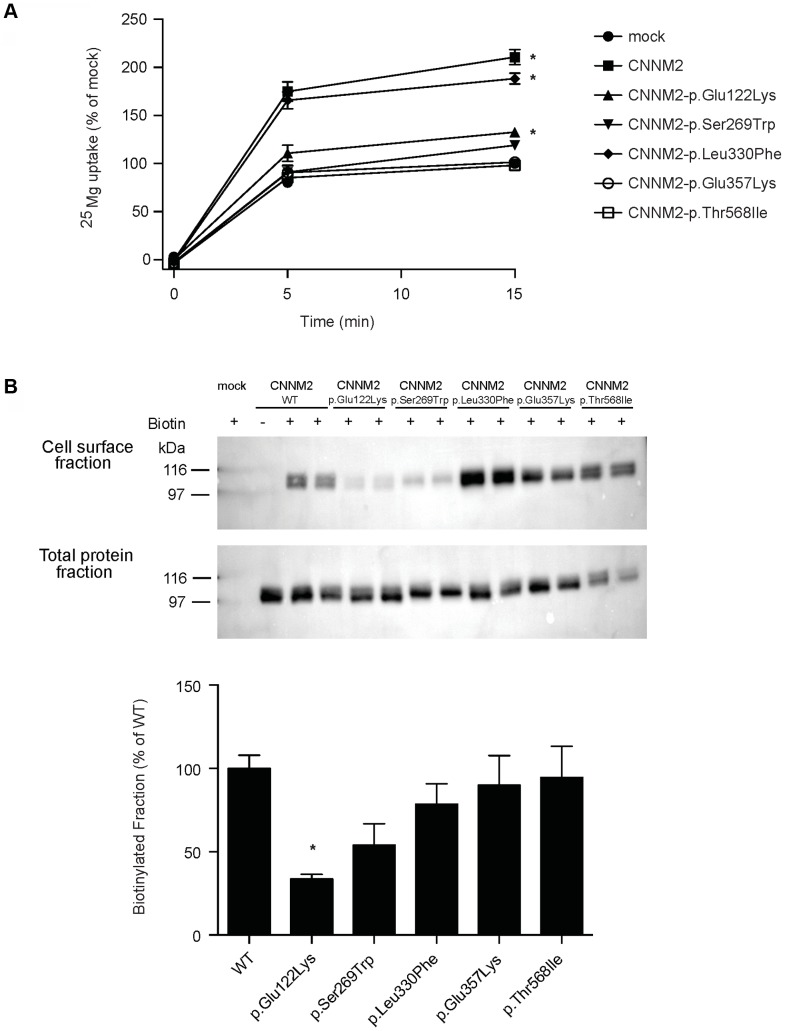
CNNM2 mutations impair Mg2+ uptake in HEK293 cells.(A) Time curve of 25Mg2+ uptake in mock, wild-type CNNM2 and mutant CNNM2 transfected cells. Symbols indicate cells transfected with the vector empty (• mock) or containing Cnnm2 sequences encoding for wild-type or mutant CNNM2 proteins (▪ CNNM2, ▴ CNNM2-p.Glu122Lys, ▾ CNNM2-p.Ser269Trp, ⧫ CNNM2-p.Leu330Phe, ○ CNNM2-p.Glu357Lys, □ CNNM2-p.Thr568Ile). Each data point represent the mean of 3 independent experiments ± SEM. * indicates significant differences compared to mock (P<0.05). (B) Representative immunoblots showing that p.Glu122Lys and p.Ser269Trp mutations reduce CNNM2 membrane expression (upper blot) and a CNNM2 expression control (lower blot). Quantification of cell surface expression of wild-type (WT) and mutant CNNM2 proteins corrected for total protein expression. Results are the mean ± SEM of 3 independent experiments. * indicate significant differences compared to WT CNNM2 transfected cells (P<0.05).